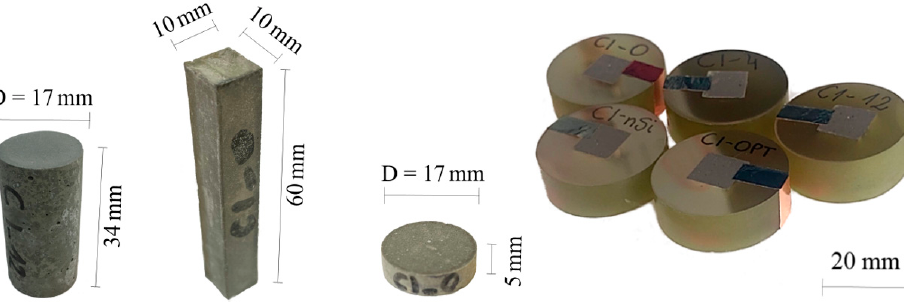
Figure 5. Types of samples used in tests.